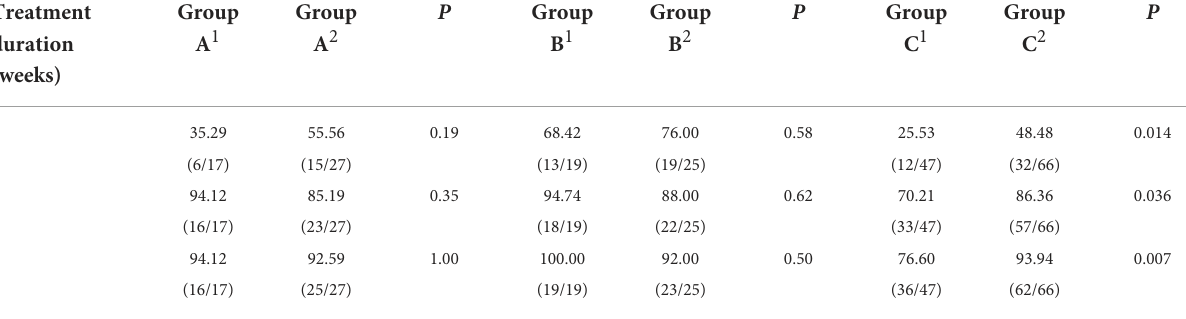
TABLE 4 Gender differences in overall gastrointestinal symptom improvement in patients with FD with mood disorders.